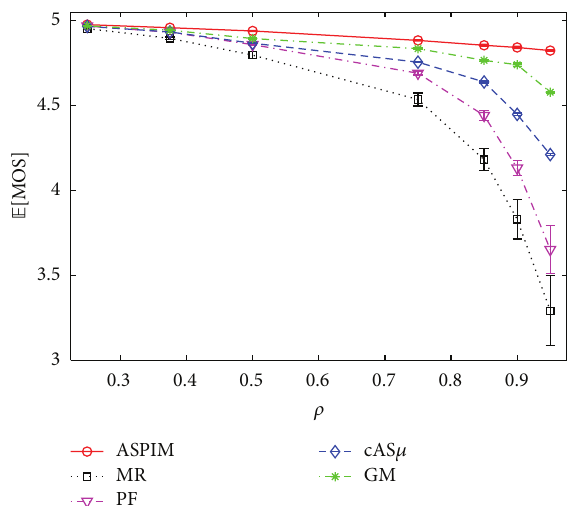
Figure 9: E [MOS] under high error due to